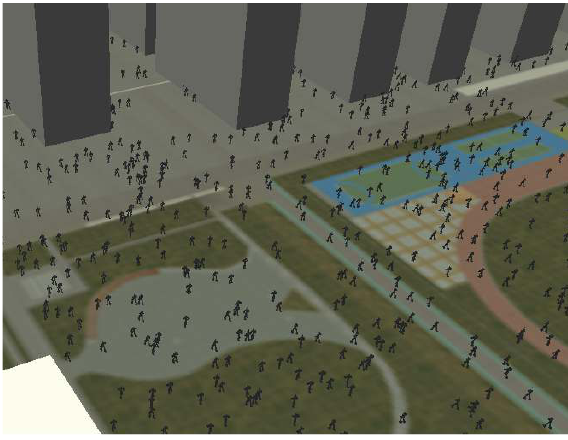
Fig. 9 Close-up of a detail in the